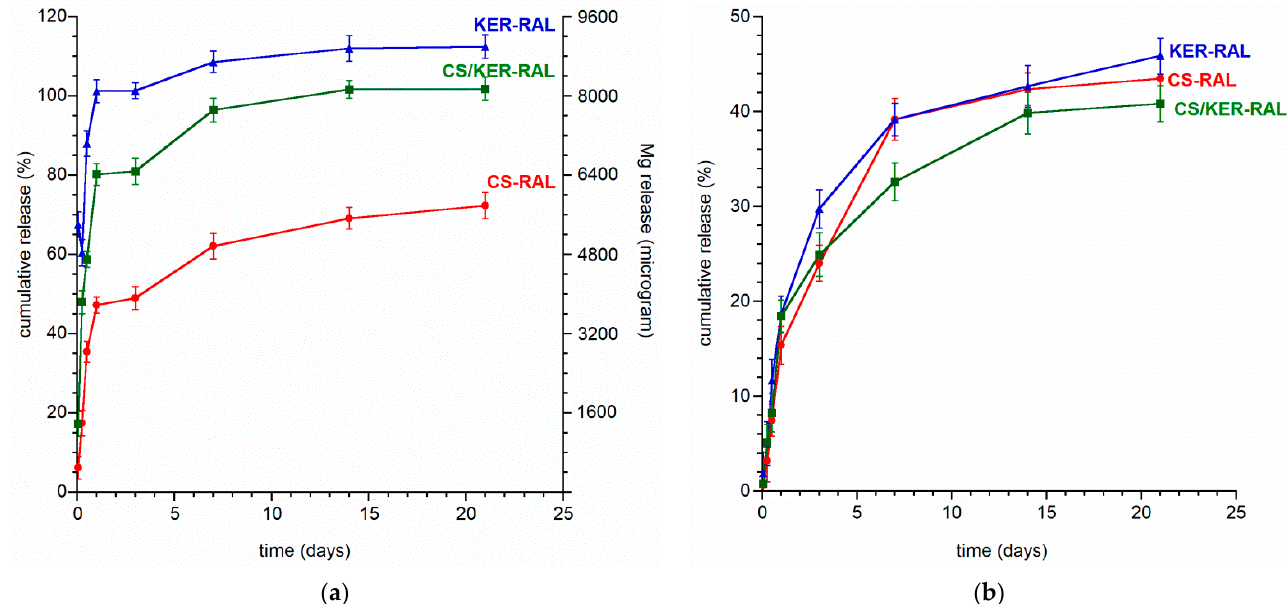
Figure 4. ( a ) The magnesium release profiles from CS-RAL, KER-RAL, and CS/KER-RAL; ( b ) the silicon release profiles from CS-RAL, KER-RAL, and CS/KER-RAL.